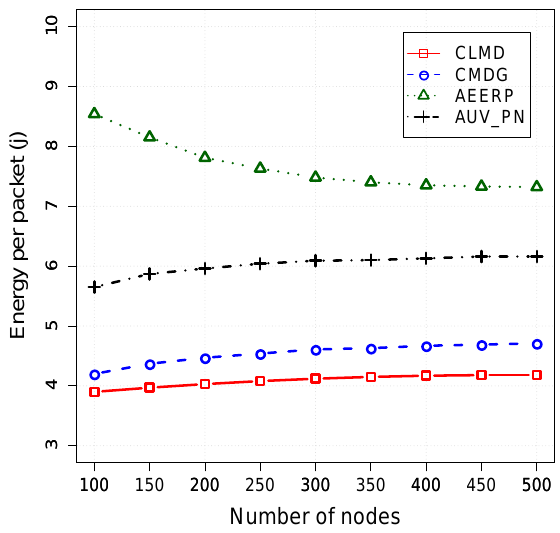
Figure 5. Energy consumption vs. node density.